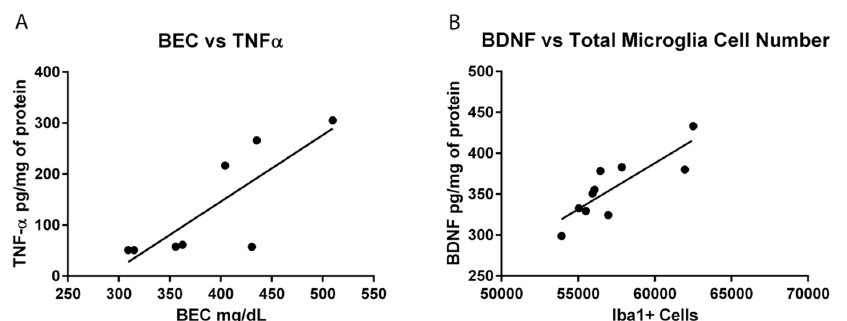
Figure 6. Increased TNF- α in EtOH/EtOH Group. Concentrations of ( A , B ) interleukin-10 (IL-10) and ( C , D ) tumor necrosis factor- α (TNF- α ) were determined by ELISA in both the hippocampus ( A , C ) and entorhinal cortex ( B , D ). No change in IL-10 was measured in either the hippocampus or the entorhinal cortex, but at least a 2.7-fold increase in TNF- α was measured in the ( C ) hippocampus in the EtOH/EtOH group compared with all other groups. However, no change in TNF- α was seen in the ( D ) entorhinal cortex. * p < 0.05 compared to ad libitum and Con/Con groups; # p < 0.05 compared to Con/EtOH.